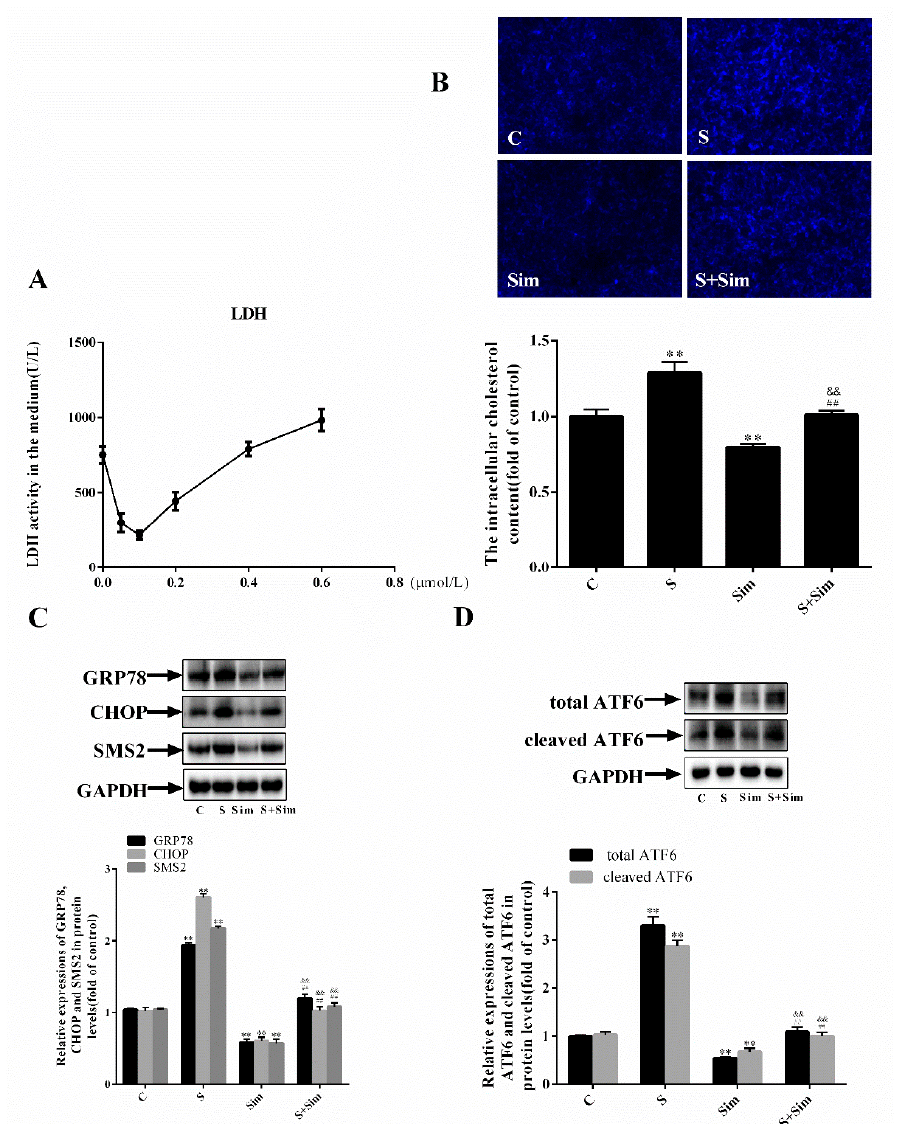
Figure 4. Overexpression of SMS2 can lead to ER stress by increasing the deposition of intracellular cholesterol. ( A ) HUVECs were treated with simvastatin at different doses (0, 0.05, 0.1, 0.2, 0.4, and 0.6 µmol/L) for 24 h, and the level of LDH in the cellular medium was detected. ( B ) The accumulation of ER cholesterol after filipin staining was visualized under a fluorescence microscope (magnification 40×). ( C ) The protein levels of GRP78 and CHOP were determined by a western blot analysis. ( D ) The protein levels of the total ATF6 and cleaved ATF6 were determined by a western blot analysis. n = 3, * p < 0.05, and ** p < 0.001 vs. the C group; ## p < 0.001 vs. the S group. && p < 0.001 vs. the Sim group. C, cells transfected with empty plasmids treated with H 2 O 2 (450 µmol/L) for 24 h; S, cells overexpressing SMS2 treated with H 2 O 2 (450 µmol/L) for 24 h; Sim, empty plasmids treated with simvastatin (0.1 µmol/L) for 24 h and then treated with H 2 O 2 (450 µmol/L) for 24 h; S+Sim, cells overexpressing SMS2 treated with simvastatin (0.1 µmol/L) for 24 h and then treated with H 2 O 2 (450 µmol/L) for 24 h.